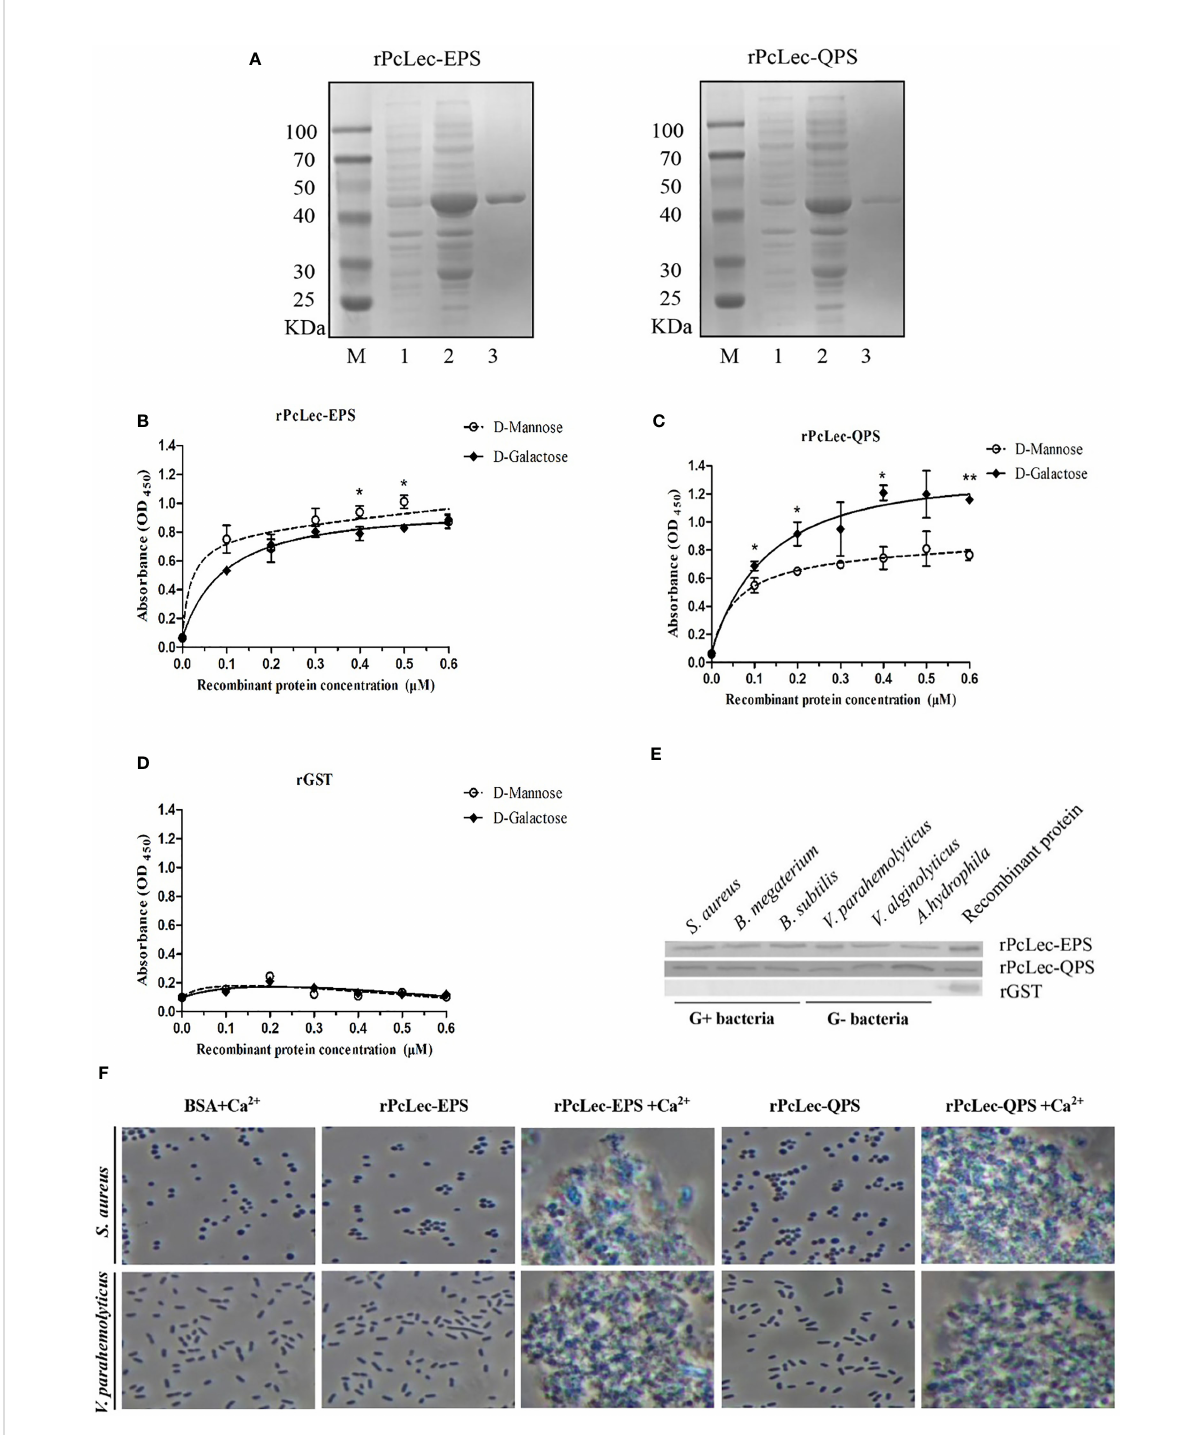
FIGURE 5 Analysis of carbohydrates binding, microbial binding, and bacterial agglutination of rPcLec-EPS and rPcLec-QPS. (A) Recombinant expression and puri fi cation of PcLec-EPS and PcLec-QPS. M: standard protein marker; Lane 1: total proteins of E. coli with recombinant plasmids without IPTG induction; Lane 2: total proteins of E. coli with recombinant plasmids induced with 0.5 mM IPTG; Lane 3: puri fi ed rPcLec-EPS and rPcLec-QPS. (B) ELISA was used to detect the binding activities of rPcLec-EPS to D-Mannose and D-Galactose. (C) Analysis of binding activity of rPcLec-QPS to D- Mannose and D-Galactose. (D) Analysis of binding activity of rGST to D-Mannose and D-Galactose. Asterisks (* p < 0.05 and ** p < 0.01) indicate that there are signi fi cant differences between two different experimental groups at the same recombinant protein concentration. (E) Analysis of binding activity of rPcLec-EPS and rPcLec-QPS to various Gram-positive and Gram-negative bacteria. (F) Agglutination of S. aureus and V. parahaemolyticus by rPcLec-EPS and rPcLec-QPS. Agglutination was observed using a microscope in the presence or absence of Ca 2+ . BSA was used as a negative